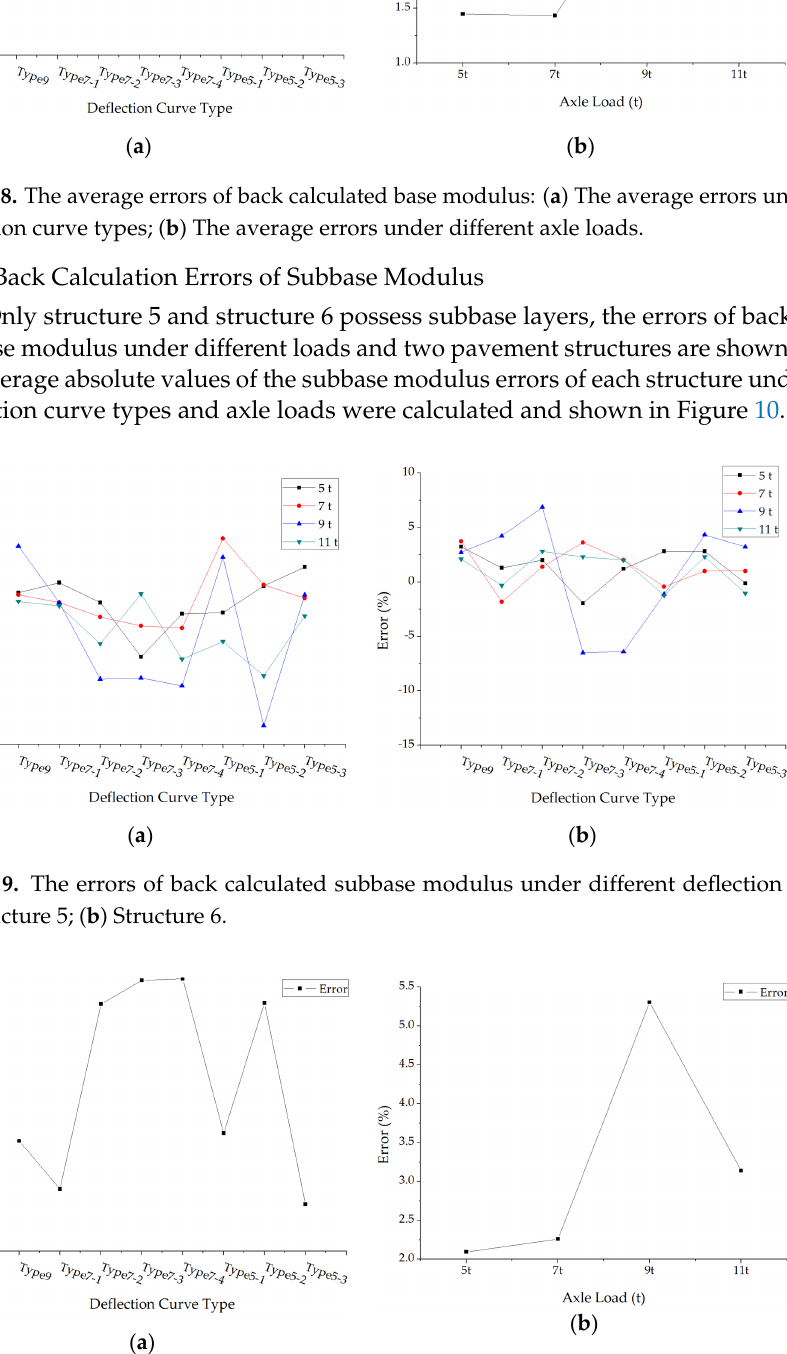
Figure 10. The average errors of back calculated subbase modulus: ( a ) The average errors under different deflection curve types; ( b ) The average errors under different axle loads.